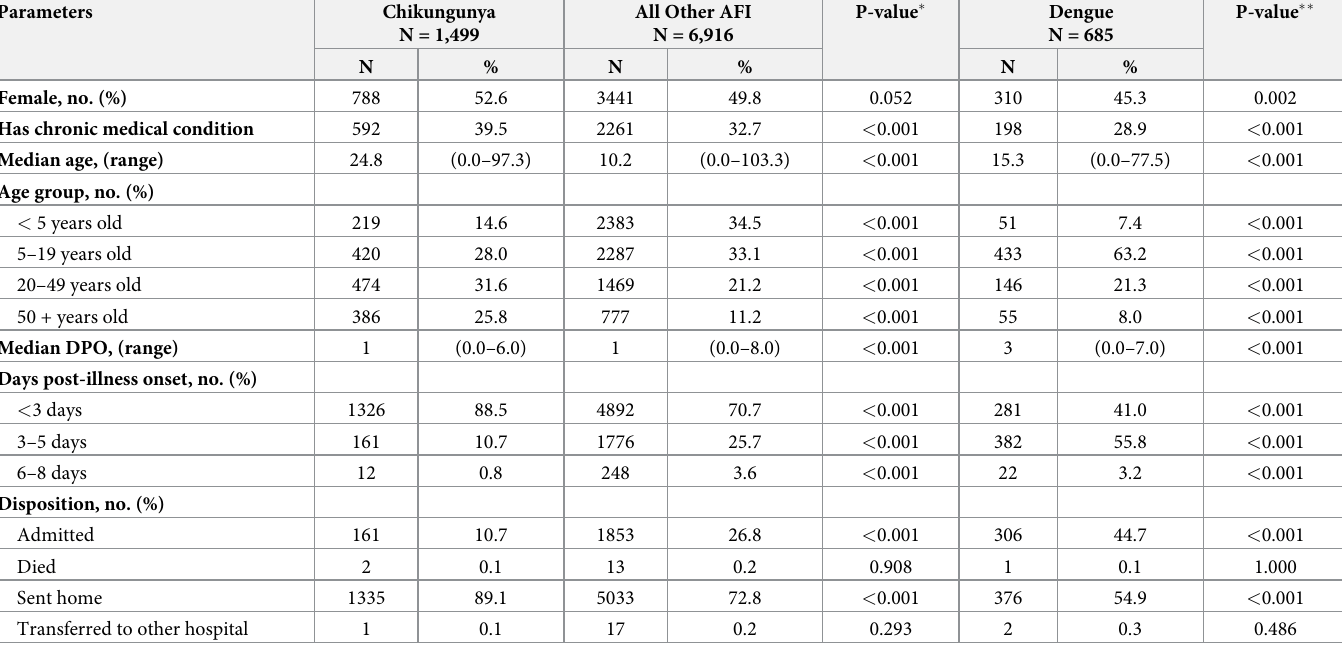
Table 1. Characteristics and clinical features of participants at study enrollment by diagnostic group, Acute Febrile Illness Study, May 7, 2012–May 6, 2015, Puerto Rico.